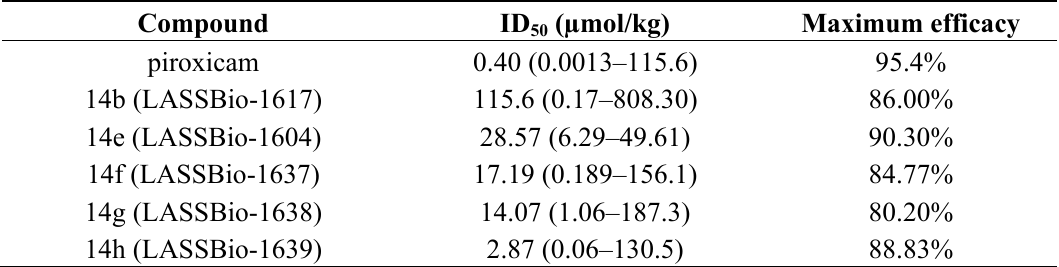
Table 2. Maximum efficacy and ID acetic acid-induced writhing test in